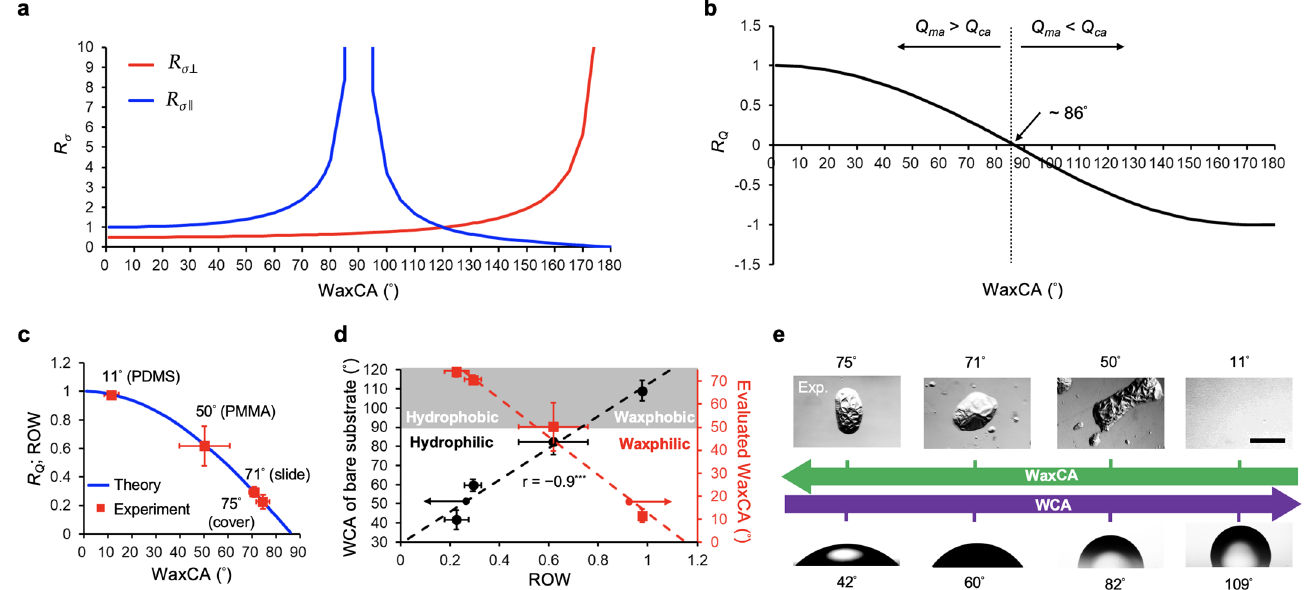
Figure 3. Theoretical characteristics of the phase transition of waxy films on underlying substrates. ( a ) Profiles R σ ⊥ and R σ ‖ versus WaxCAs from 0° to 180°. ( b ) Profile of R Q versus WaxCAs from 0° to 180°. The critical WaxCA was 86° when Q ma = Q ca . ( c ) Theoretical trend between the ratio of competed flow rate ( R Q ≡ ROW) and the wax contact angle (WaxCA). The WaxCA of substrates was evaluated by fitting the measured ROWs accordingly. ( d ) Relationship between the WCA or the WaxCA and the ROW on different substrates after heating the coated wax film at 65 °C for 30 s. ( e ) Summary of the trend between WCA and WaxCA derived from different substrates. Scale bar = 200 μ m. Data represent the mean ± SD, n = 4. Pearson’s r = − 0.9 (*** p < 0.001) indicated a significantly reversed trend between WCA and WaxCA in ( e ).